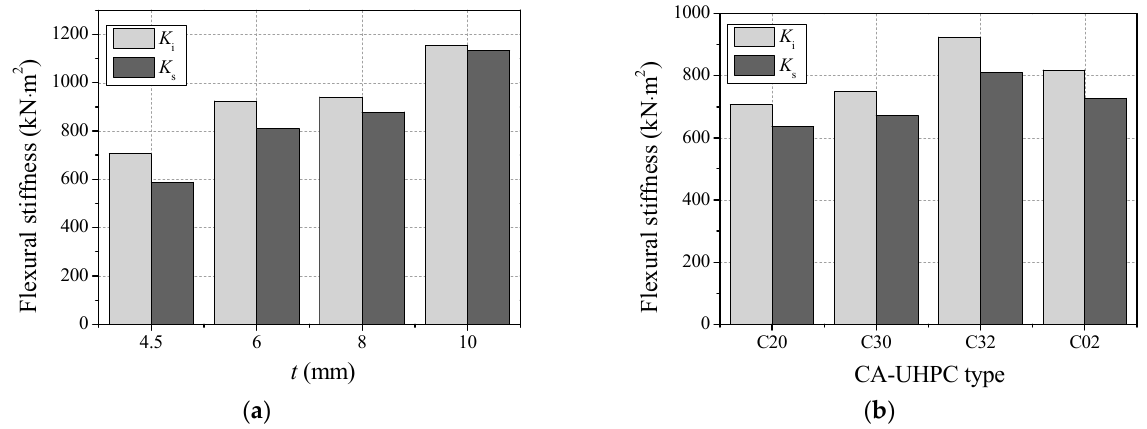
Figure 11. The flexural stiffness of CA-UHPCFSTs. ( a ) The effect of steel tube thickness; ( b ) the effect of CA-UHPC type.